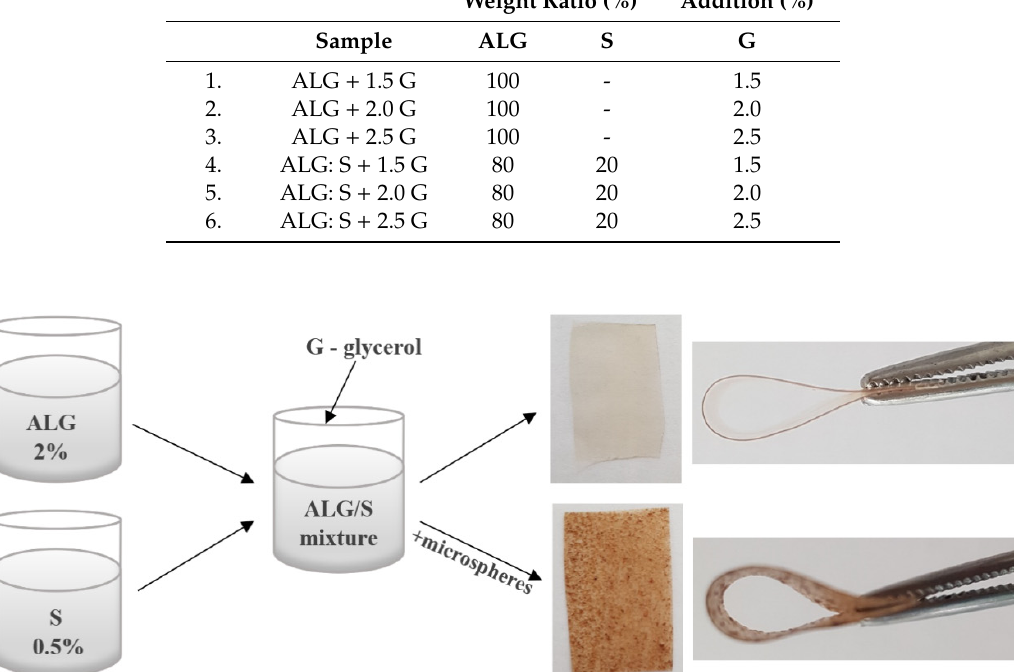
Figure 2. The scheme of production of sodium alginate/starch films with and without microspheres. Table 1. The composition of the prepared films (ALG—sodium alginate, S—starch, G—glycerol). Weight ratio (%)